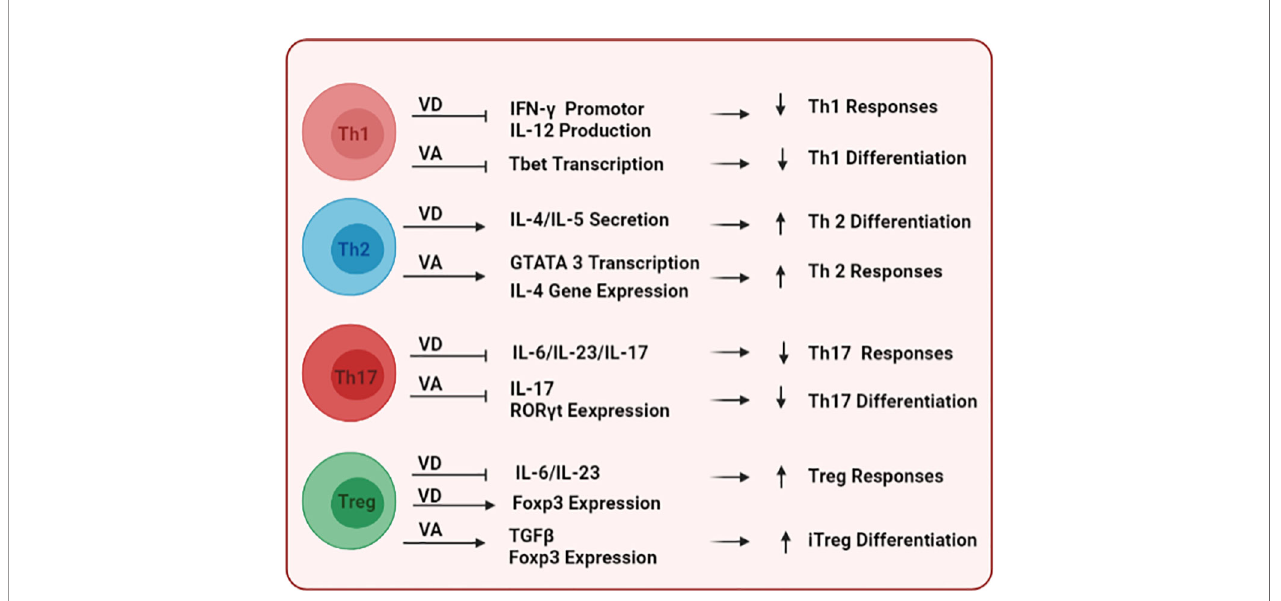
FIGURE 2 | The immunomodulatory effects of vitamins D and A on T cells. Following their binding to DNA responsive elements of target genes, both vitamins differentially modulate key transcription factors and stimulatory cytokine signals to shape the commitment and functional responses of multiple T-cell subsets including Th1, Th2, Th17, and